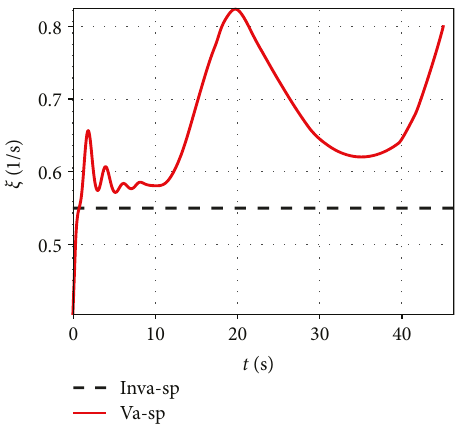
Figure 12: Curves representing the attack, sideslip, and bank angles. Inva_sp: invariable span; Va-sp: variable span.